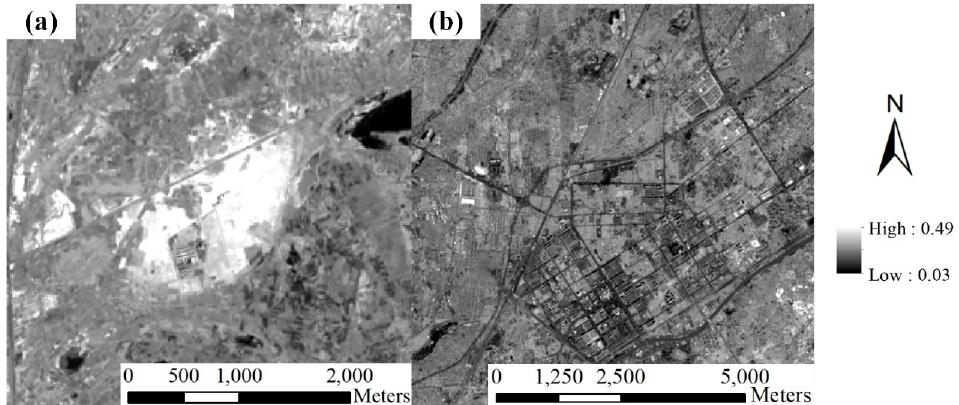
Figure 7. Example of SI map of ( a ) the abandoned salinized farmland and ( b ) the residential area.